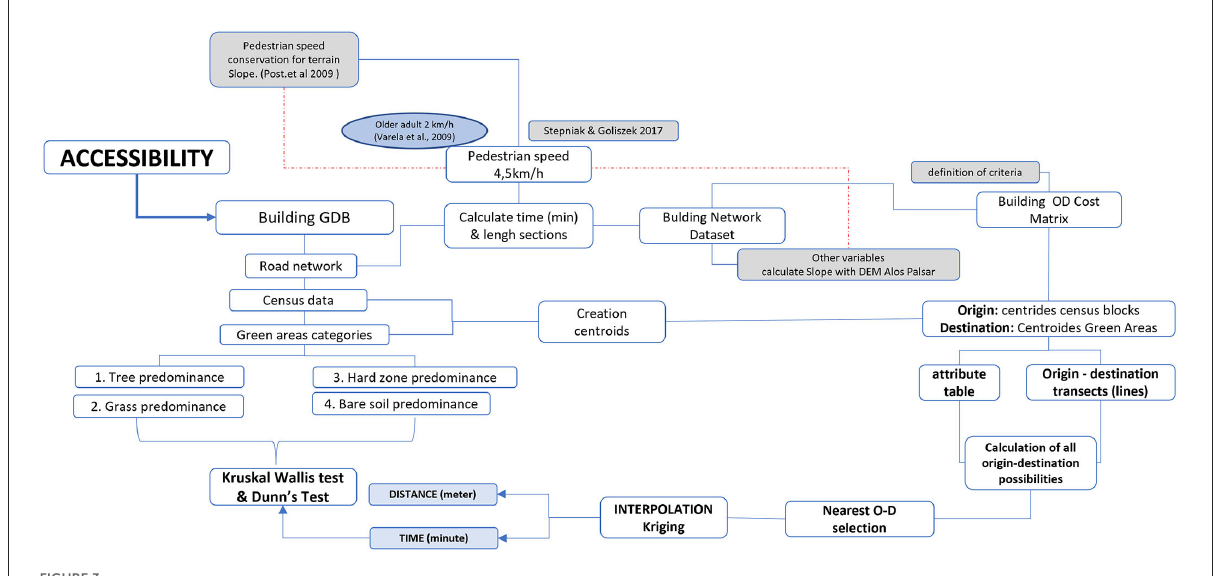
FIGURE3 Summary of the accessibility analysis. Source: Prepared by the